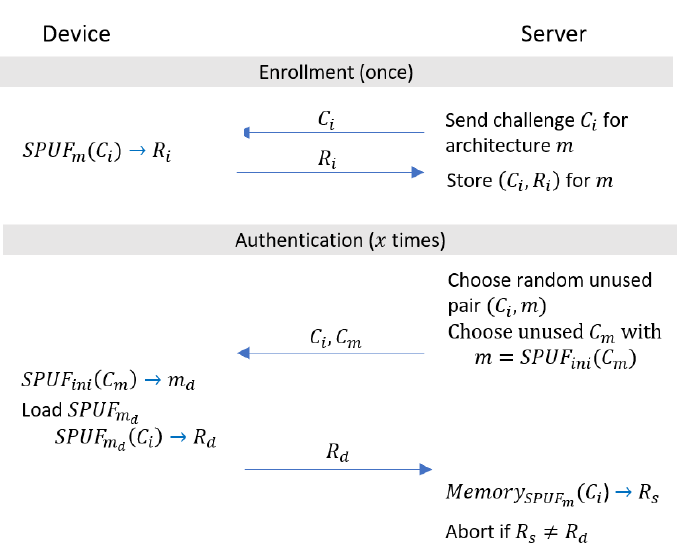
Figure 6. Our RESA-P authentication protocol, which hides the PUF architecture m , from which the CRP ( C i , R ) for authentication is